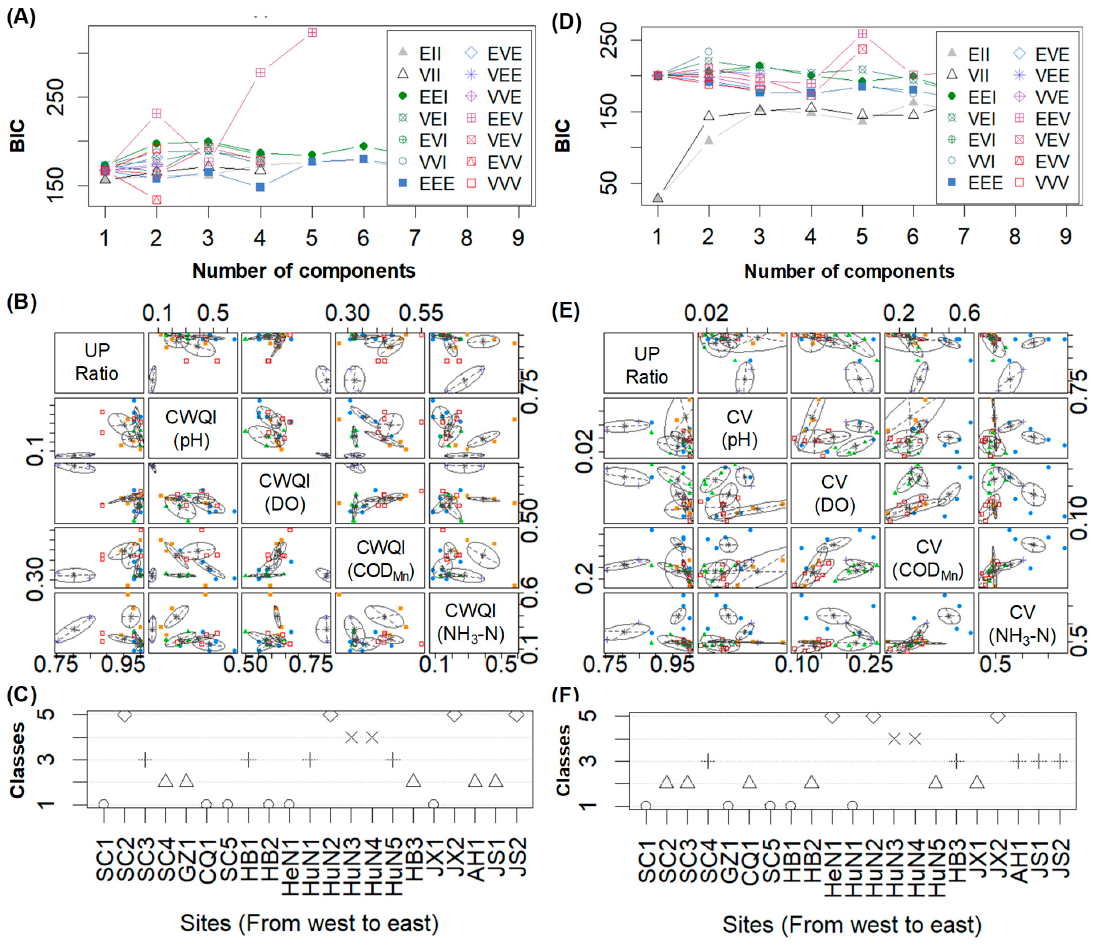
Figure 6. Classification of the 21 sites using EM clustering algorithms based on ratios of unpolluted weeks and yearly SWQI (i)s of pH, DO, COD Mn , and NH 3 –N ( A – C ); and on ratios of unpolluted weeks and CV (i)s of weekly means of pH, DO, COD Mn , and NH 3 –N ( D – F ). Note: Diamonds, x crosses, crosses, triangles and circles in ( C ) and ( F ) indicate different EM clusters.